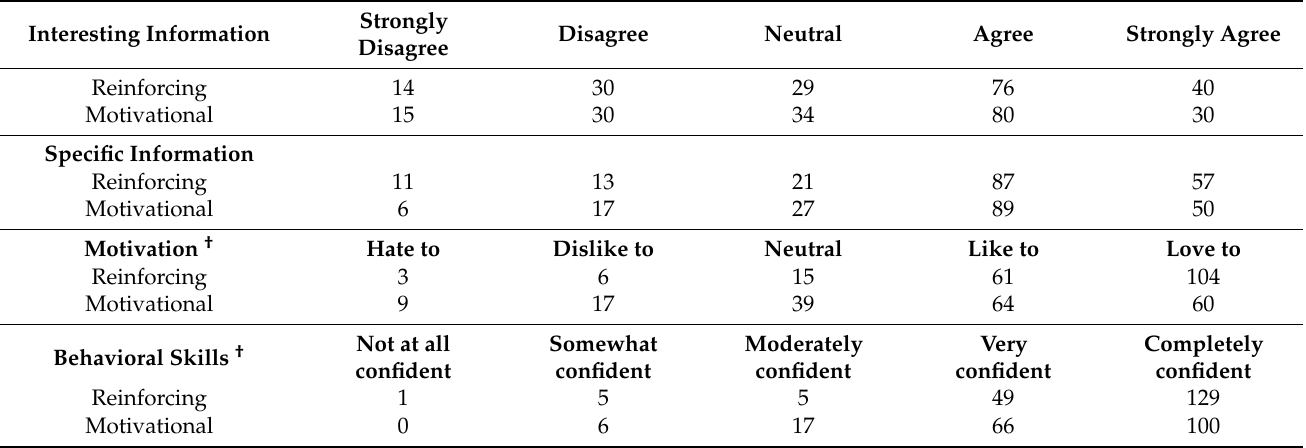
Table 5. Number of participants ( n = 189) who fell into each response category for message types that were reinforcing or motivation according to information, motivation, and behavioral